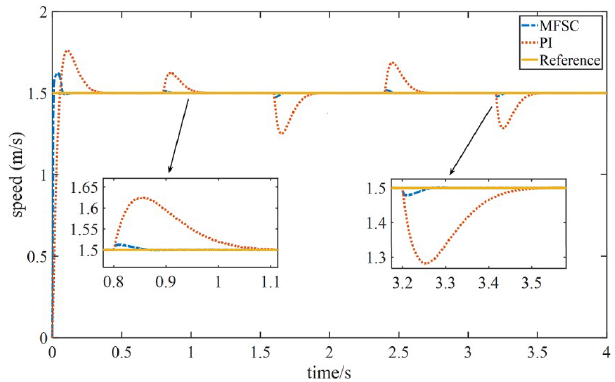
Figure 8. The thrust waveforms of the two controllers under vari- able load motion are compared.